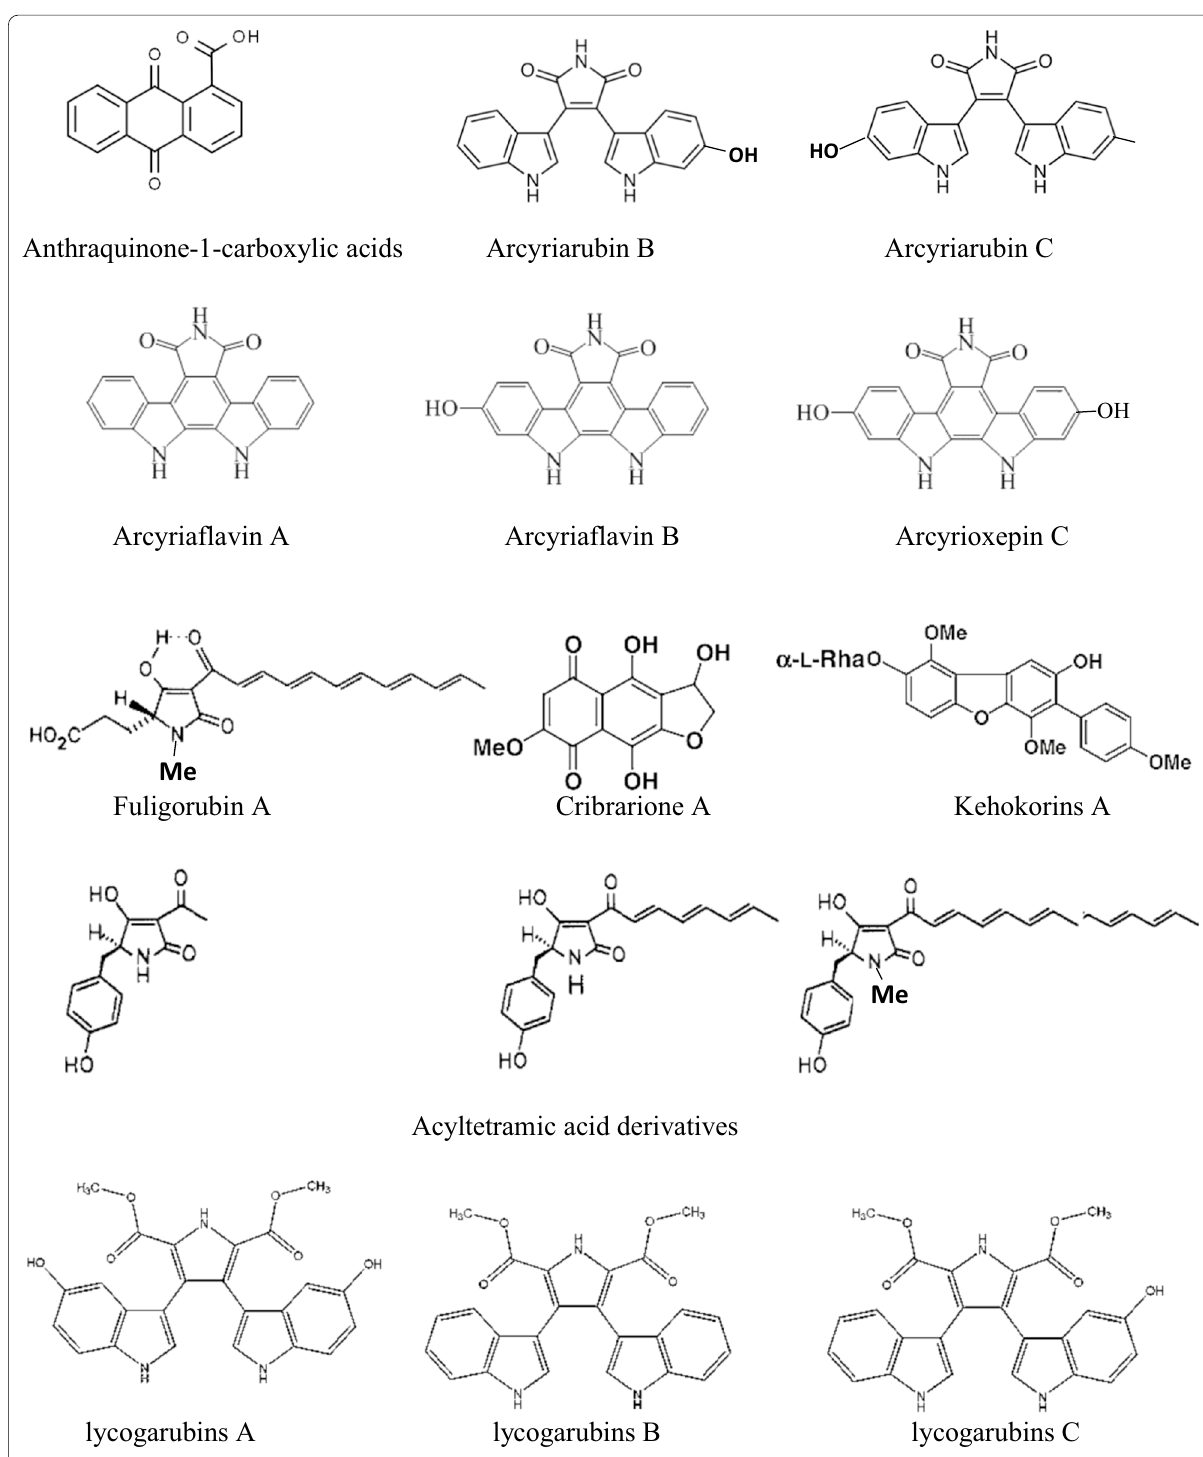
Fig. 11 Pigment components from slime molds with antimicrobial